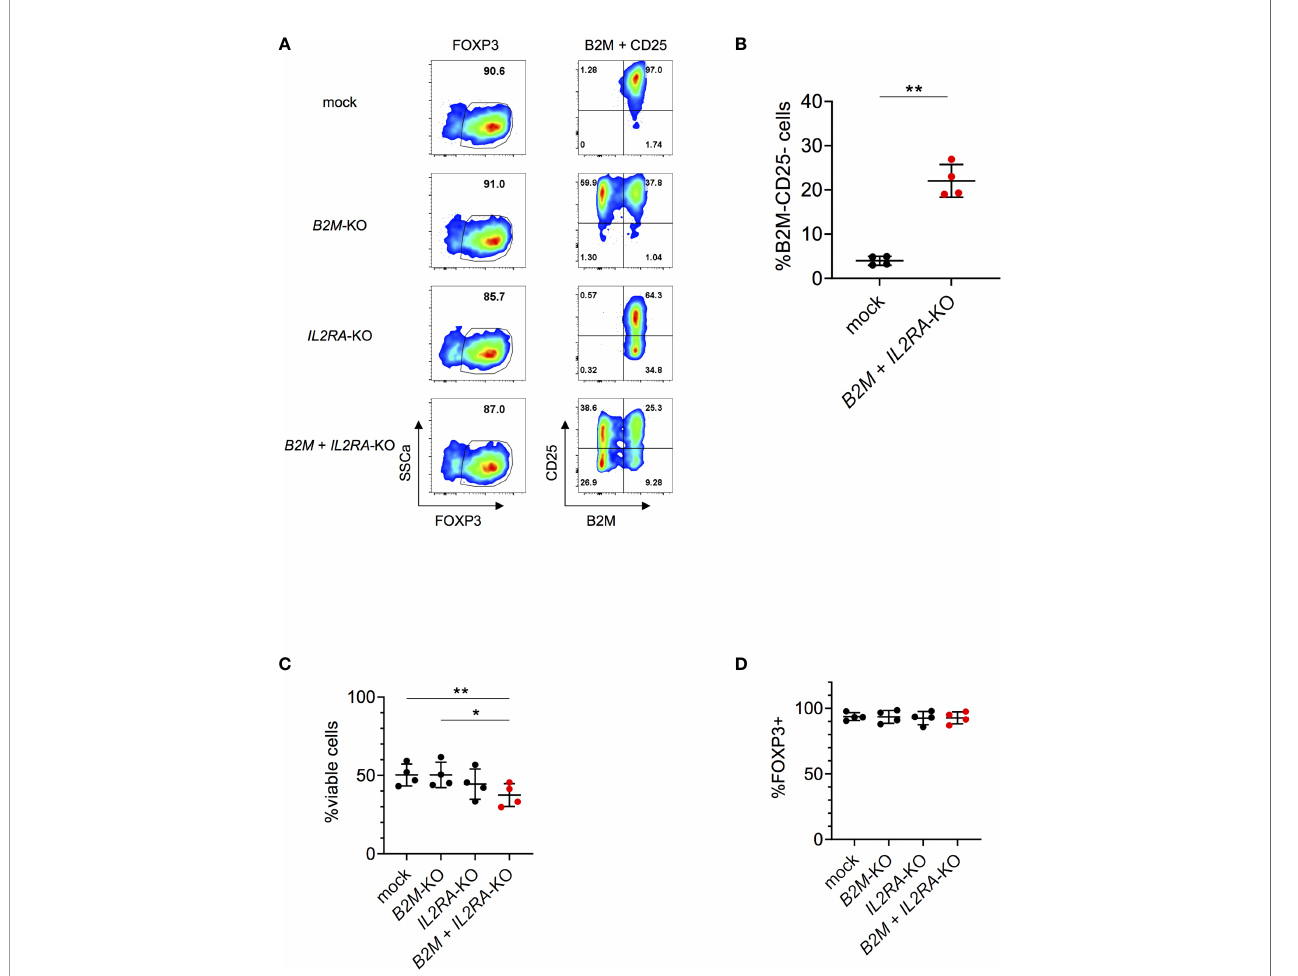
FIGURE 3 | Ef fi cient multiplexing of B2M and IL2RA- KO in human Tregs. (A) Human Tregs were cultured in vitro for 7 days prior gene editing (following protocol described in Figure 1A ). FOXP3, CD25 and B2M expression were analyzed in mock, B2M -KO, IL2RA -KO and double KO Tregs that were harvested 4 days after RNP nucleofection. FOXP3 plots are pre-gated on living cells. Plots showing B2M/CD25 expression are pre-gated on living FOXP3 + cells. Data are from one representative experiment out of 4. (B) Percentages of double KO of B2M and IL2RA in human Tregs were analyzed 4 days after nucleofection (n = 4 independent donors). Error bars represent mean ± SD. (C) Viability of B2M and IL2RA single and double KO Tregs was measured 4 days after nucleofection (n = 4 independent donors). Error bars represent mean ± SD. (D) FOXP3 expression of B2M and IL2RA single and double KO Tregs (pre-gated on living cells) was measured 4 days after nucleofection (n = 4 independent donors). Error bars represent mean ± SD. Statistical signi fi cance was calculated by a two-tailed paired t test (B) and one-way ANOVA (C, D) . *p ≤ 0.05, **p ≤